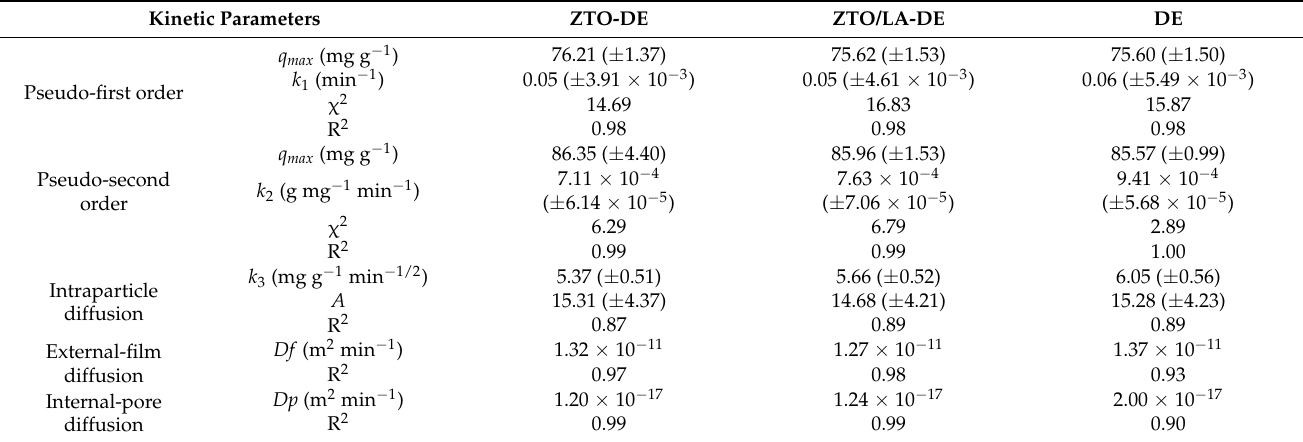
Figure 9. Intra-particle diffusion plots for MB removal by the extrudates. Table 4. Kinetic parameters for MB removal in